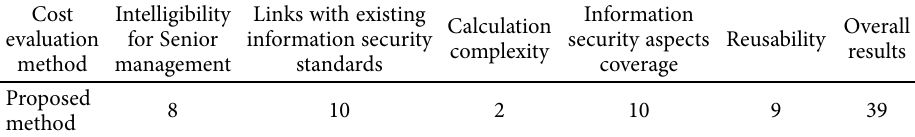
Table 5. Proposed method